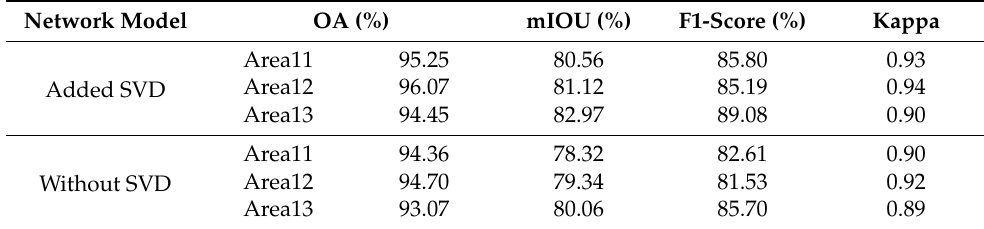
Table 4. The evaluation metrics from operation with and without